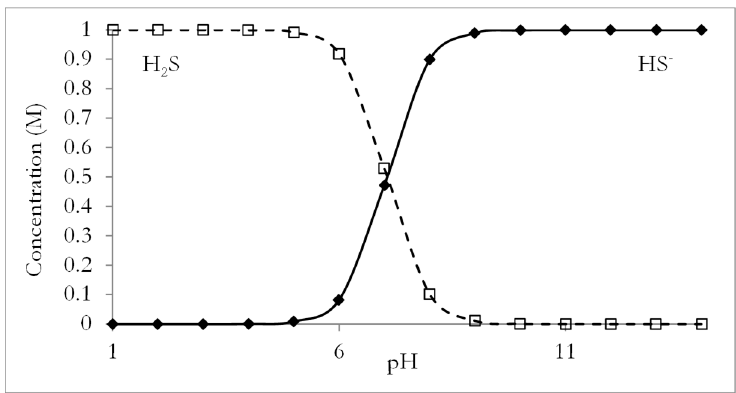
Figure 1. Illustrating the variation of concentrations of dissolved hydrogen sulphide (H 2 S) and bisulfide (HS − ) in an aqueous solution with pH of the digester.